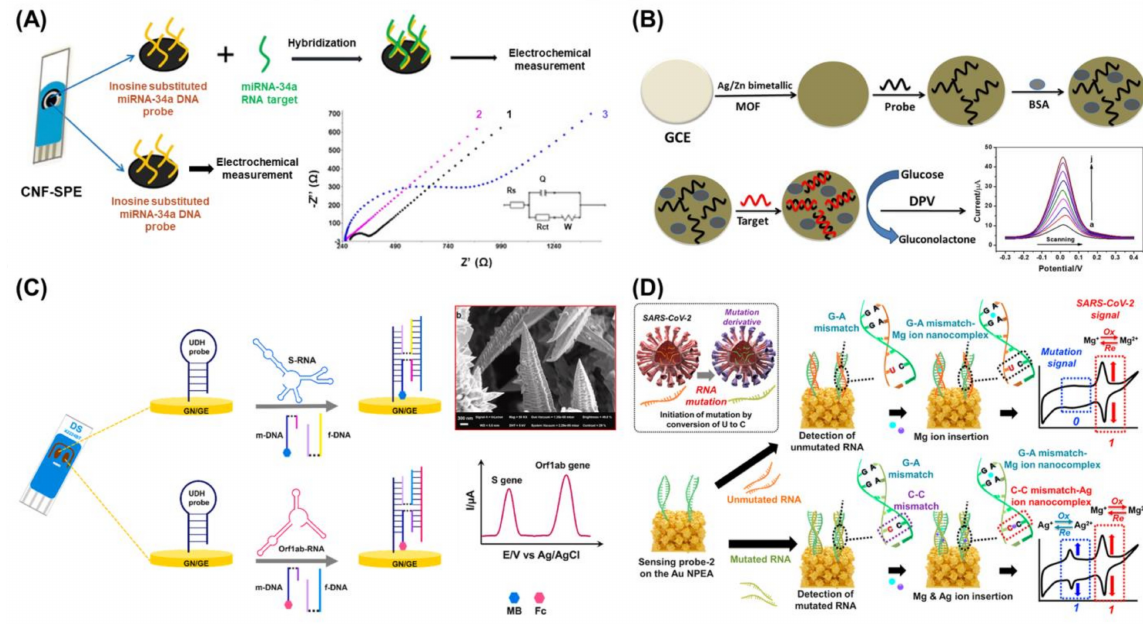
Figure 3. ( A ) Schematic diagram of indicator-free electrochemical biosensor for miRNA-34a detection, and Nyquist plot results of bare SPE (1), CNF-SPE (2), and after detection of miRNA-34a (3). Reprinted with permission from Ref. [84]. Copyright © 2015 Elsevier B.V. ( B ) Schematic diagram of fabrication assisted HCV RNA detection using DPV technique. Reprinted with permission from Ref.